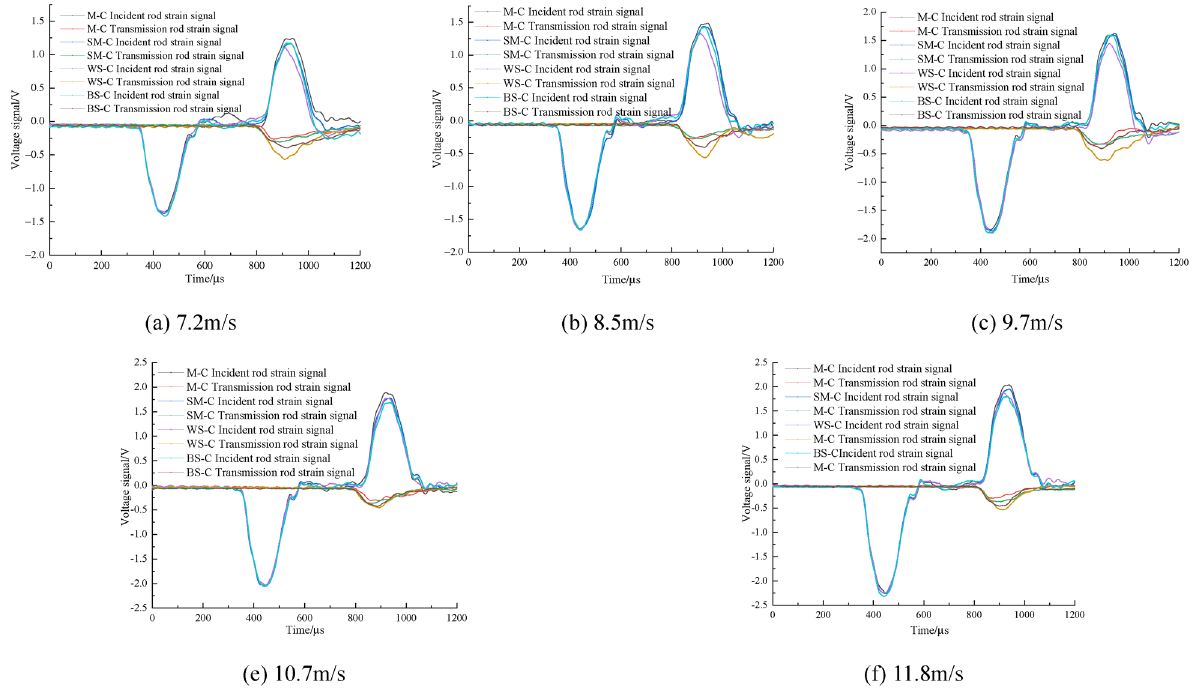
Figure 5. The waveforms in CRCB specimens at different impact